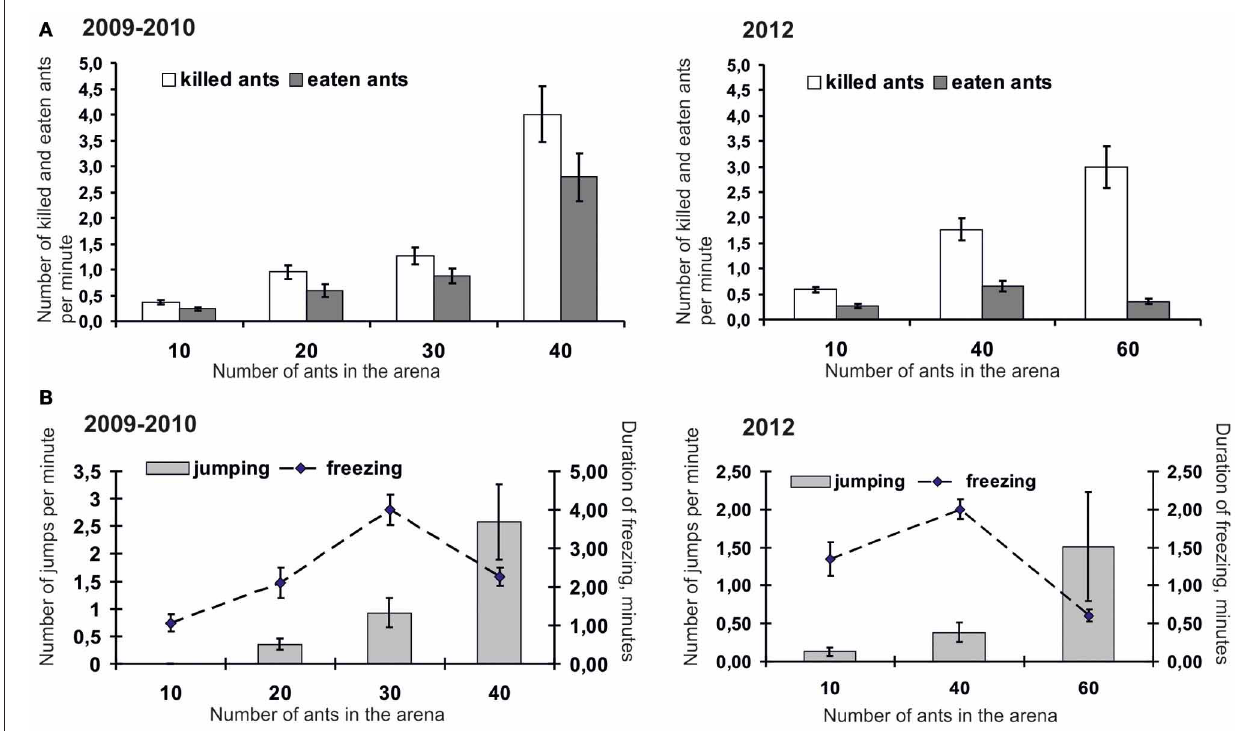
FIGURE 2 | Number of ants killed and eaten by mice (A), and number of signs of dismay in mice (B) placed in the arena together with different number of ants (Mean ± SE). Note for the two left graphs: data with 10 ants were obtained in 2009, and the rest were obtained in